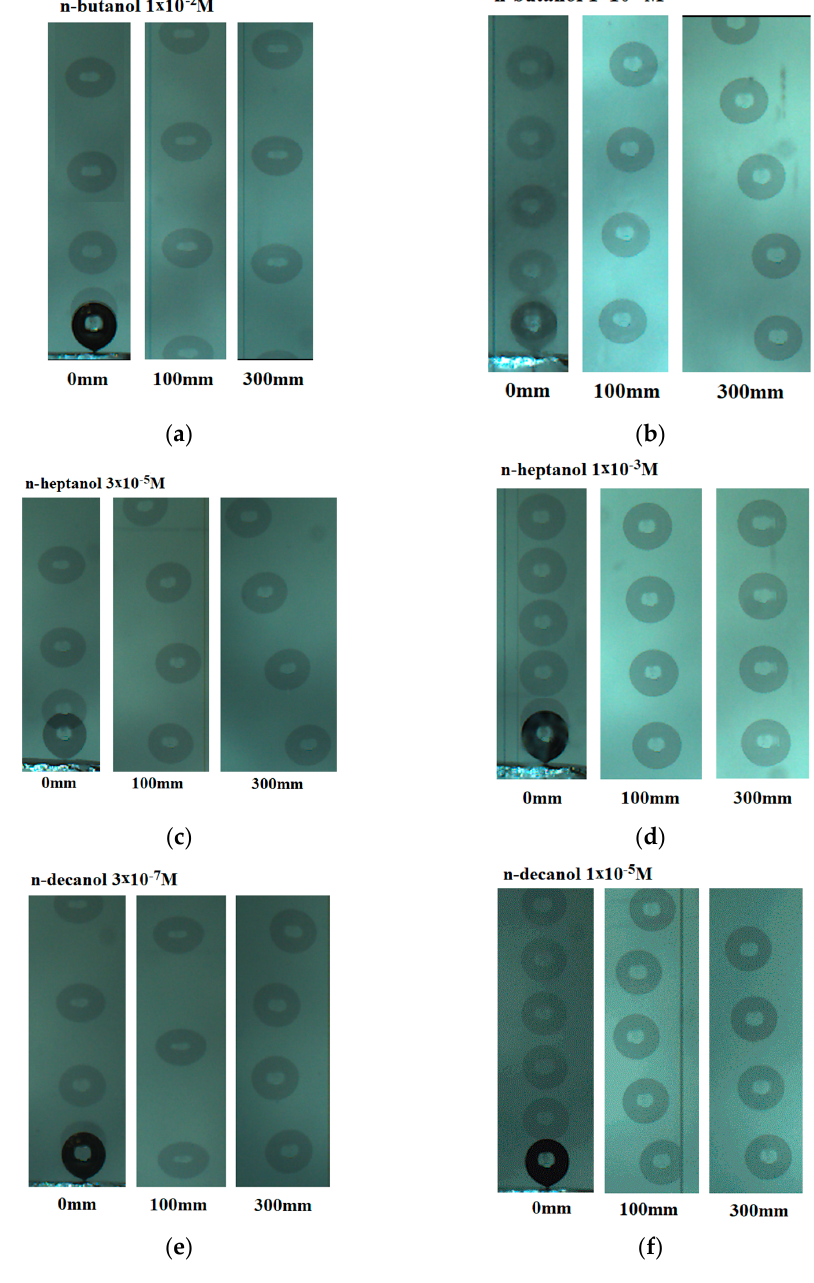
Figure 1. Images of bubbles rising in various n-alkanol solutions. ( a ) 1 × 10 − 2 M n-butanol; bubble diameter: 1.48 ± 0.01 mm; all experiments were recorded with a flash frequency of 100 Hz (0.01 s interval between images of the rising bubble). ( b ) 1 × 10 − 1 M n-butanol; bubble diameter: 1.37 ± 0.01 mm; experiments close to the capillary (0 mm) were recorded with a flash frequency of 100 Hz, and other experiments (100 and 300 mm from the capillary) were recorded with a flash frequency of 75 Hz (0.13 s interval between images of the bubble). ( c ) 3 × 10 − 5 M n-heptanol; bubble diameter: 1.45 ± 0.02 mm; all experiments were recorded with a flash frequency of 100 Hz. ( d ) 1 × 10 − 3 M n-heptanol; bubble diameter: 1.42 ± 0.02 mm; experiments close to the capillary (0 mm) were recorded with a flash frequency of 100 Hz, and other experiments (100 and 300 mm from the capillary) with a flash frequency of 75 Hz. ( e ) 3 × 10 − 7 M n-decanol; bubble diameter: 1.44 ± 0.02 mm; all experiments were recorded with a flash frequency of 100 Hz. ( f ) 1 × 10 − 5 M n-decanol; bubble diameter: 1.43 ± 0.02 mm; experiments close to the capillary (0 mm) were recorded with a flash frequency of 100 Hz, and other experiments (100 and 300 mm from the capillary) were recorded with a flash frequency of 75 Hz.